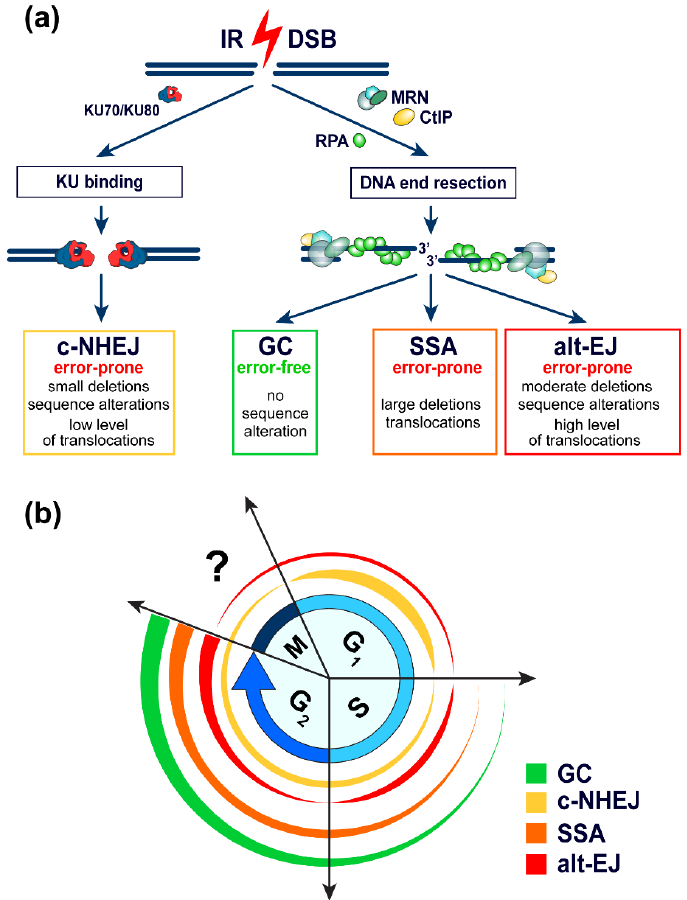
Figure 2. ( a ) Repair of DSBs by DNA end resection independent and DNA end resection